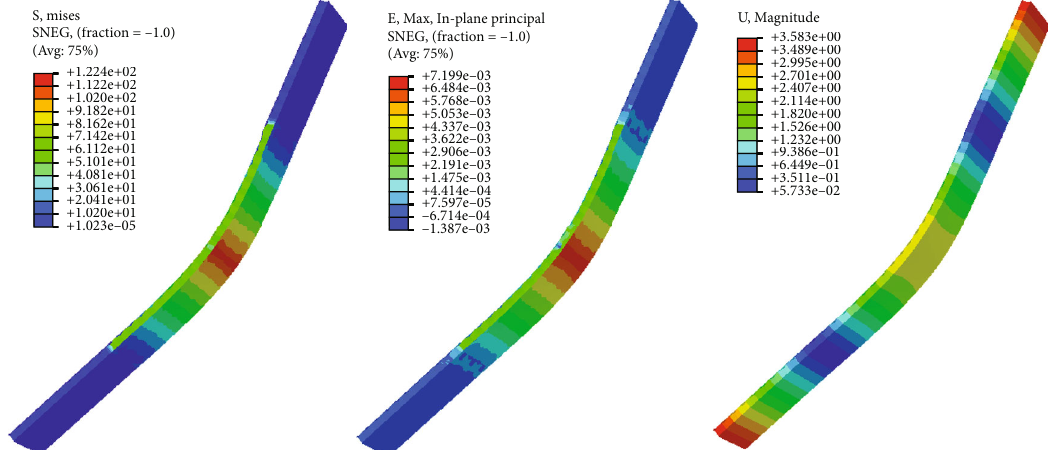
Figure 7: Stress, strain, and displacement nephograms of actual model from the lower panel